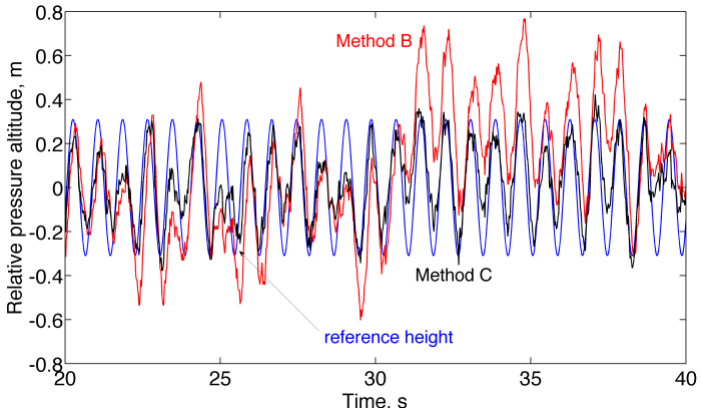
Figure 7. Forced circular motion experiment. The reference height is superimposed to the relative pressure altitudes estimated by Method B and Method